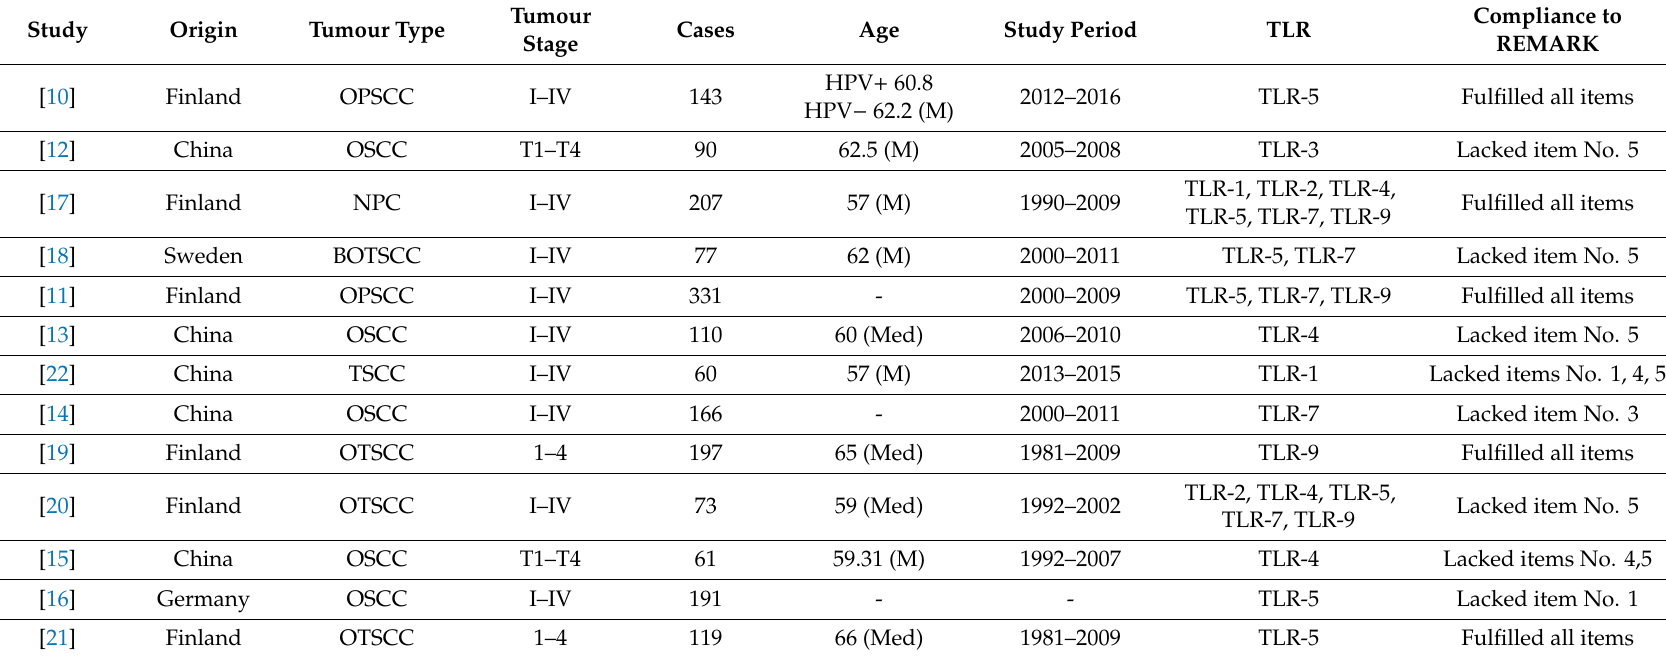
Table 1. General characteristics of the included